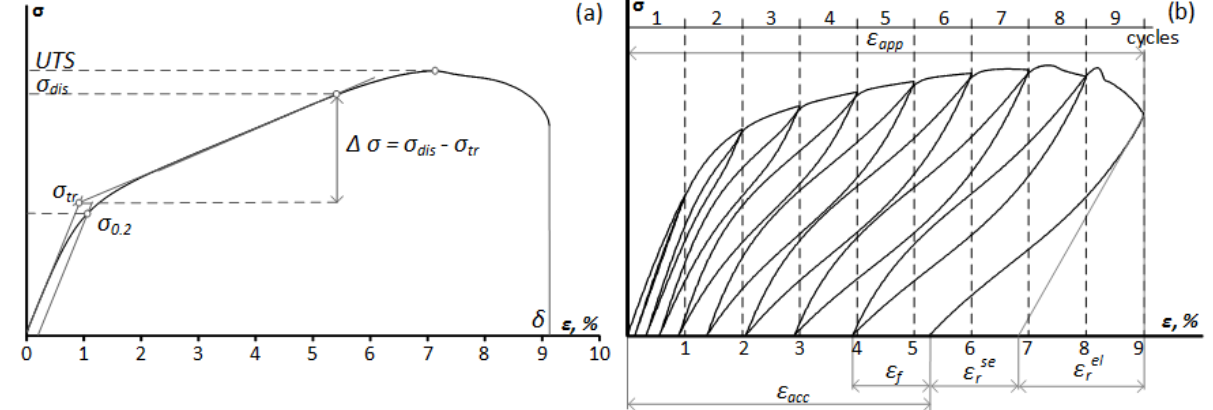
Figure 1. Schematic representation of the different metrics derived from the stress–strain diagrams obtained during: ( a ) static tensile testing to failure and ( b ) cyclic loading–unloading testing with incrementally increased